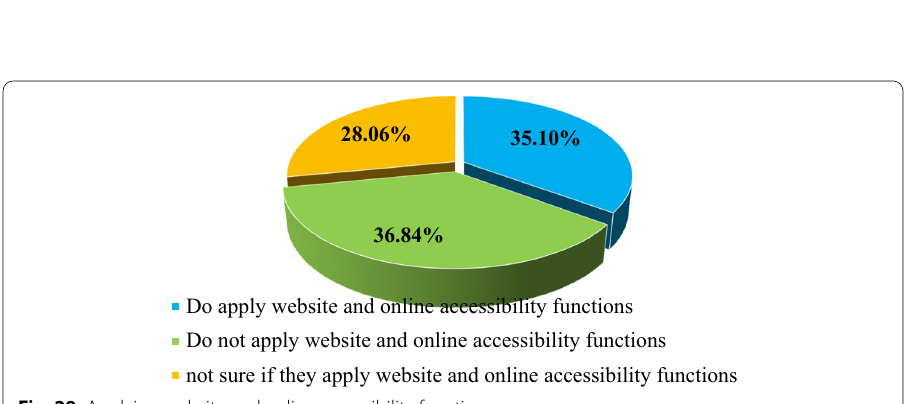
Fig. 29 Applying website and online accessibility